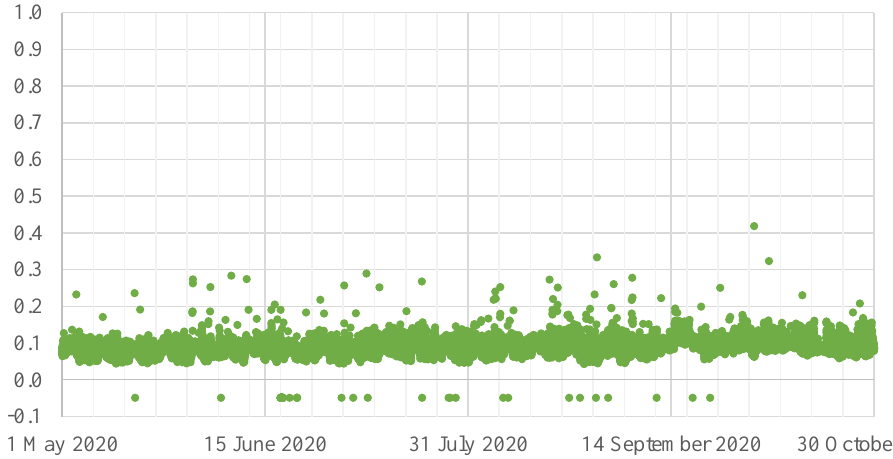
Figure 5. Global power quality index changeability for LV_L.